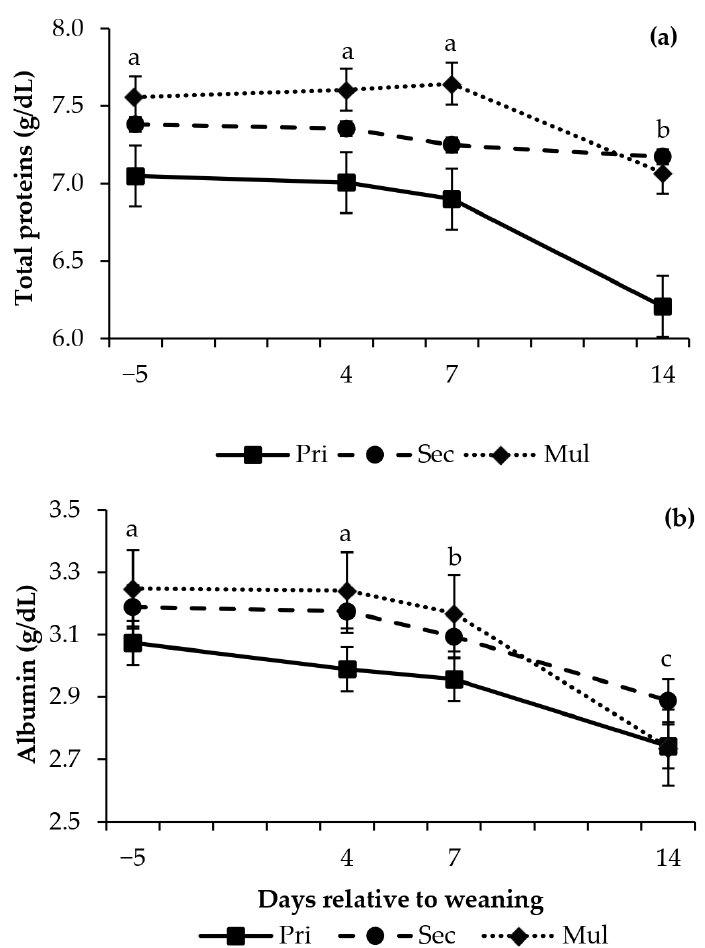
Figure 3. Total proteins ( a ) and albumin ( b ) serum concentrations in Nellore cows with different parity under grazing according to the days relative to weaning. Days with different superscripts differ from each other for all parity orders ( p < 0.05).